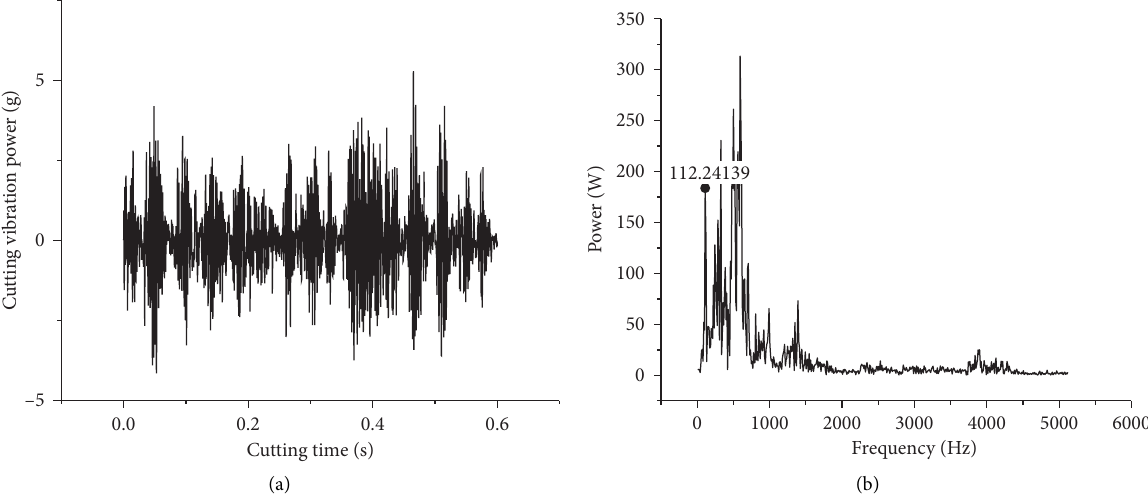
Figure 4: Cutting vibration time domain (a) and frequency domain (b).